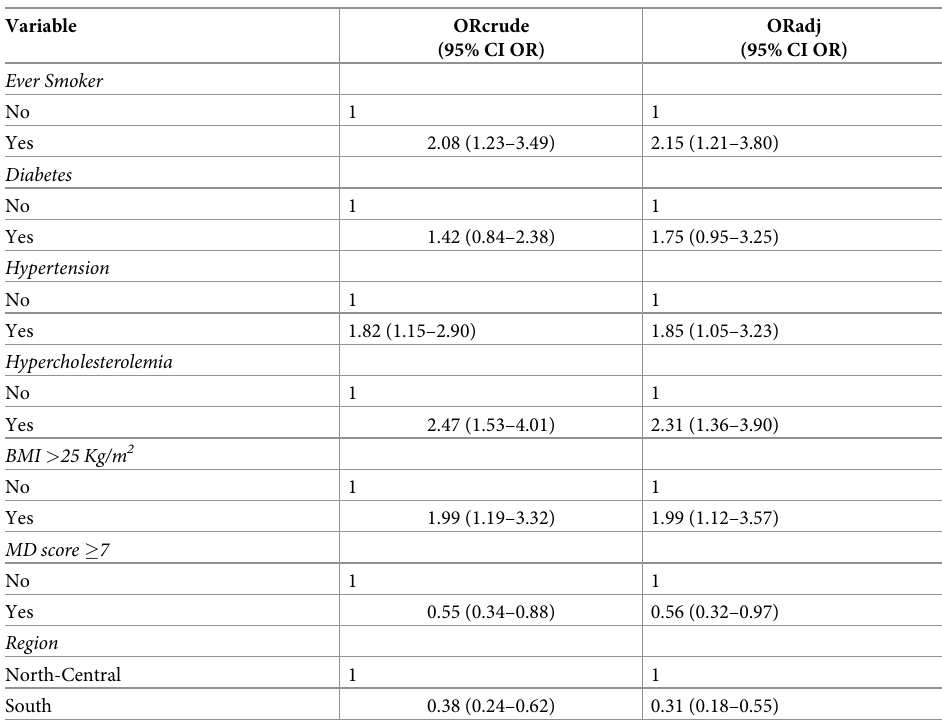
Table 3. Results of multivariate analysis (outcome variable = case of